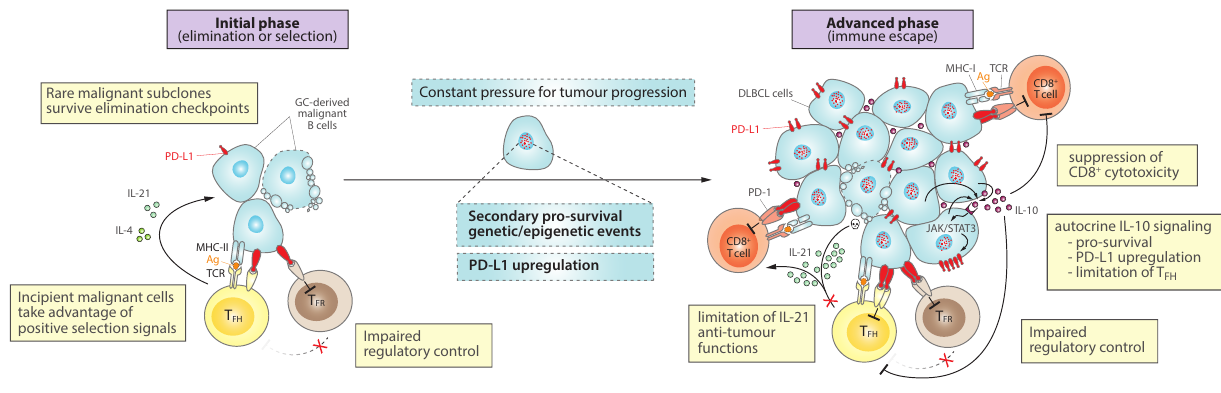
Figure 2. Role of the PD-1/PD-L1 axis and cytokine dysregulation in a progression model for DLBCL. ( Left ) At an initial phase, incipient malignant B cells that arise during GC reactions might take advantage of positive selection signals derived from correct antigen-presentation and PD-1/PD-L1 checkpoint in order to survive and initiate clonal expansion. Then, constant pressures during tumour evolution promote the acquisition of additional genetic/epigenetic mutations and PD-L1 upregulation, contributing to tumour maintenance and progression. ( Right ) At more advanced stages, DLBCL cells tend to exhibit higher PD-L1 levels and capacity to secrete IL-10, which cooperatively promote an immunosuppressive microenvironment that helps DLBCL to escape from anti-tumour CD8 + cytotoxic activity and sustain proliferation and survival, impairing regulatory control by T FR cells and limiting IL-21-mediated anti-tumour functions of T FH cells. MHC-I, major histocompatibility complex-I; Ag,